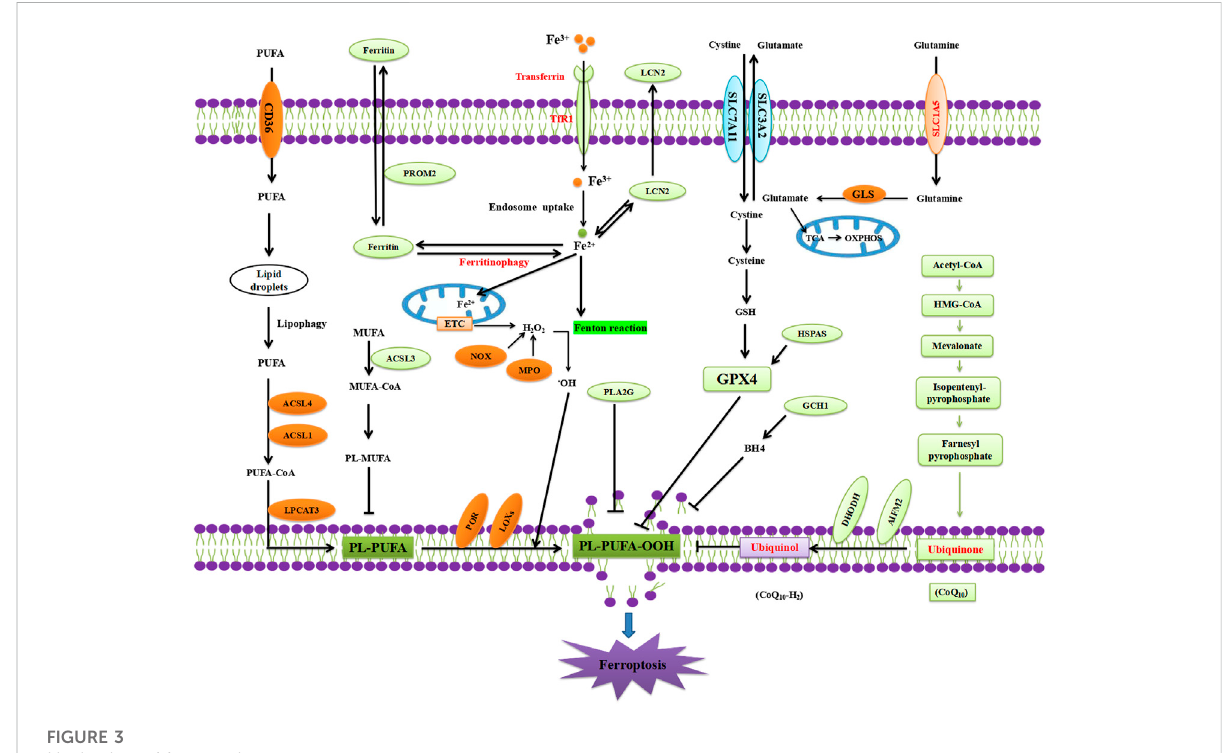
FIGURE 3 Mechanism of